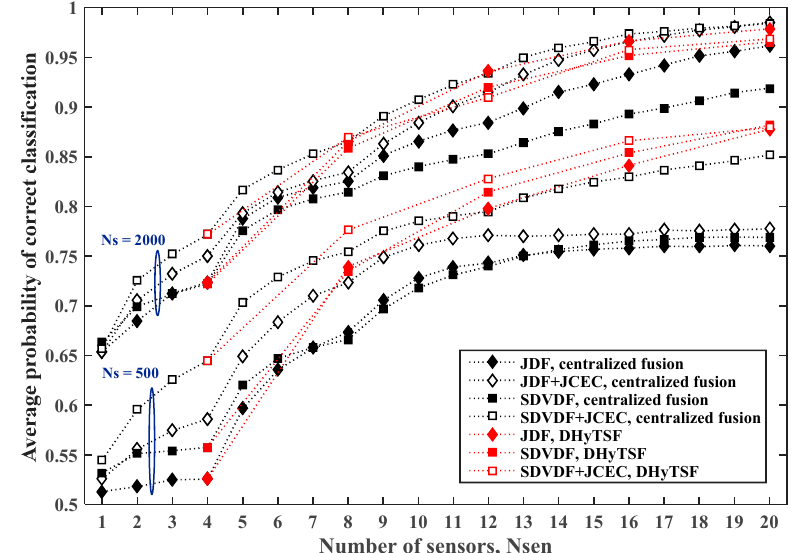
Figure 11. The estimated P CC , avg value for the centralized and distributed cooperative MC in SNS3, for N S = 500 and N S = 2000 and less dispersive environment ( L max = 5 ).